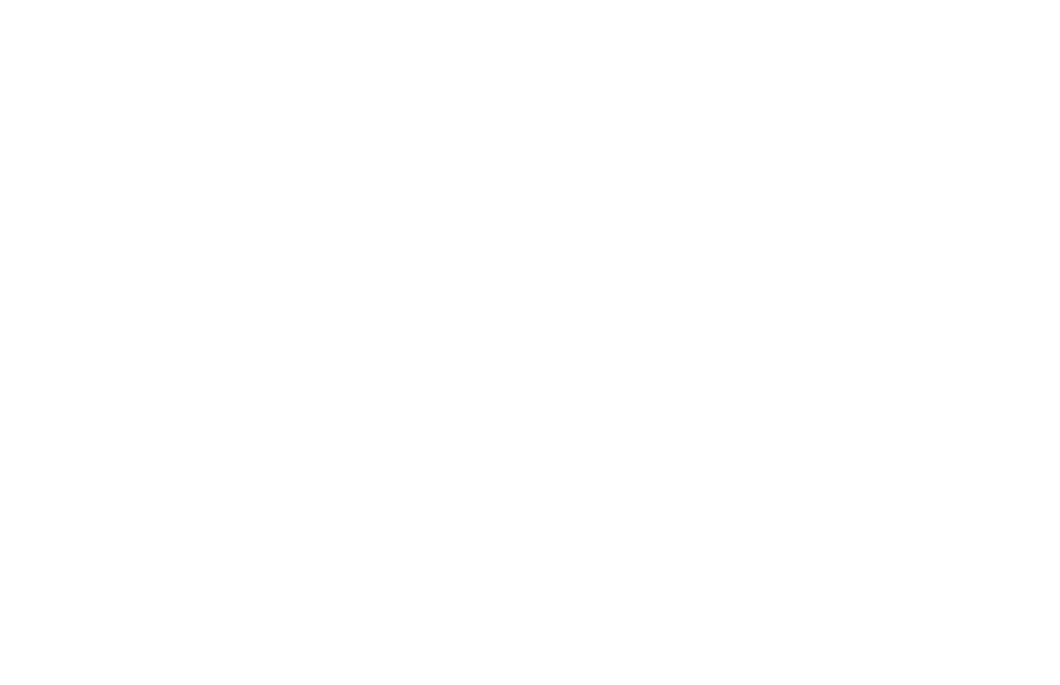
Figure 7. Electrostatic potential head-on collision between GSs for ( a ) N hc = 0.1 > K v and ( b ) N hc = 0.001 < K v with r = 0, q = 3.5, N ec = 0.4, σ = 3.5 and δ =